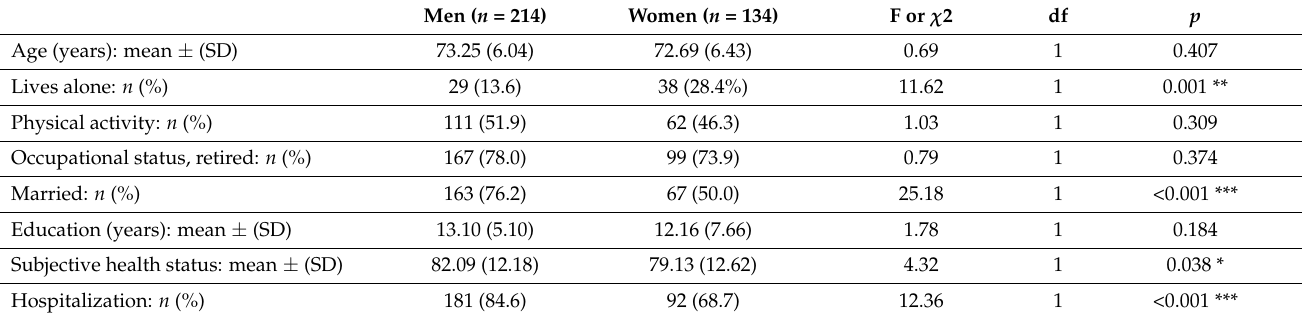
Table 1. Sociodemographic and clinical characteristics of the sample ( n = 348) according to gender. Men ( n =